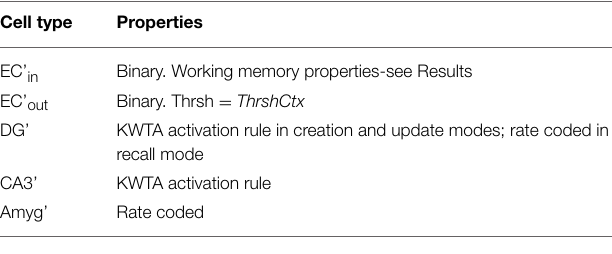
TABLE 1 | Properties of BACON